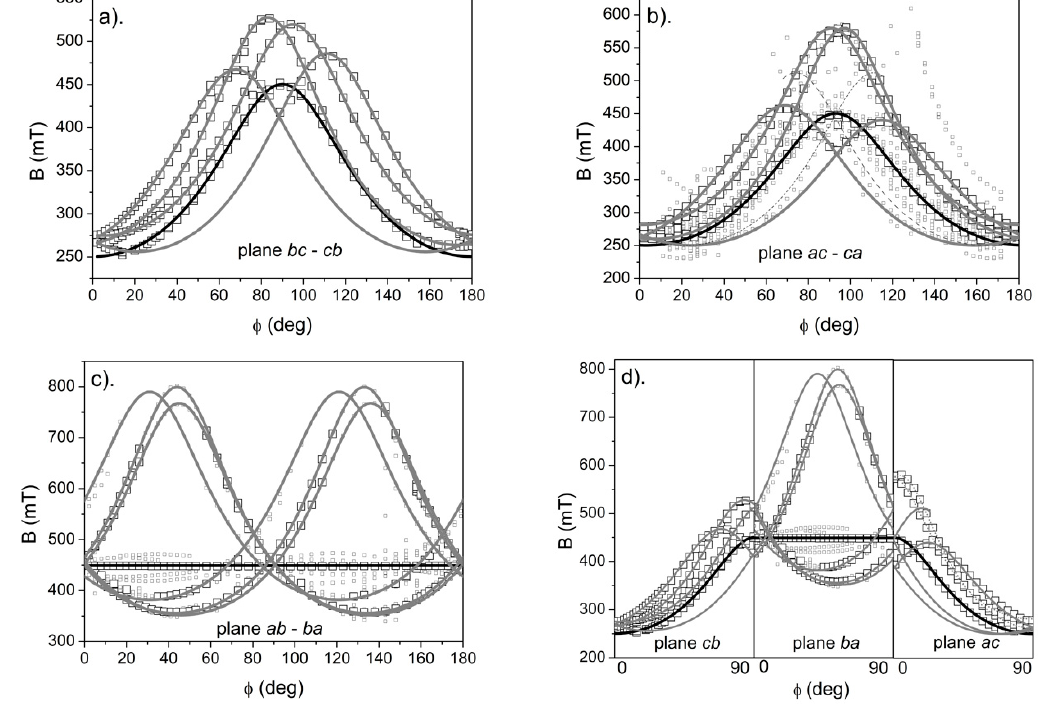
Figure 7. ( a – c ). Angular dependencies (roadmaps) along three directions a , b , and c of the BaWO 4 :